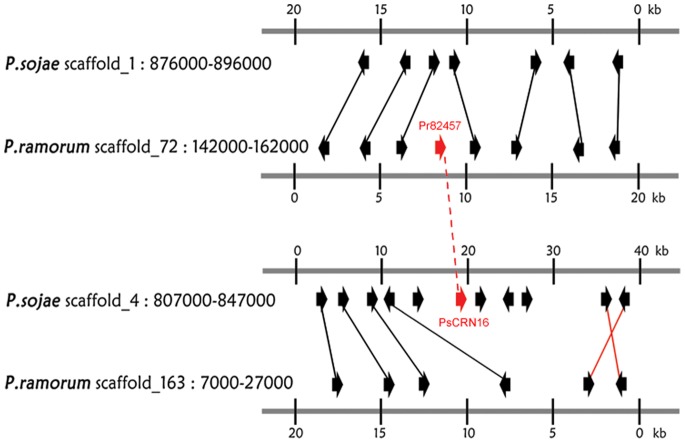
CRN effectors disrupt regions of collinear gene order.Filled red arrows represent two orthologous CRN genes. Collinear orthologous gene pairs are connected by black (direct) or red (inverted) lines.